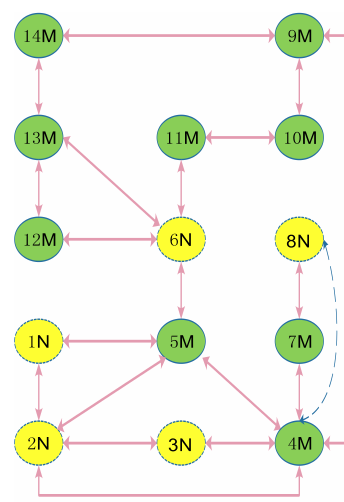
Figure 3. Multi-agent system for IEEE 14 bus